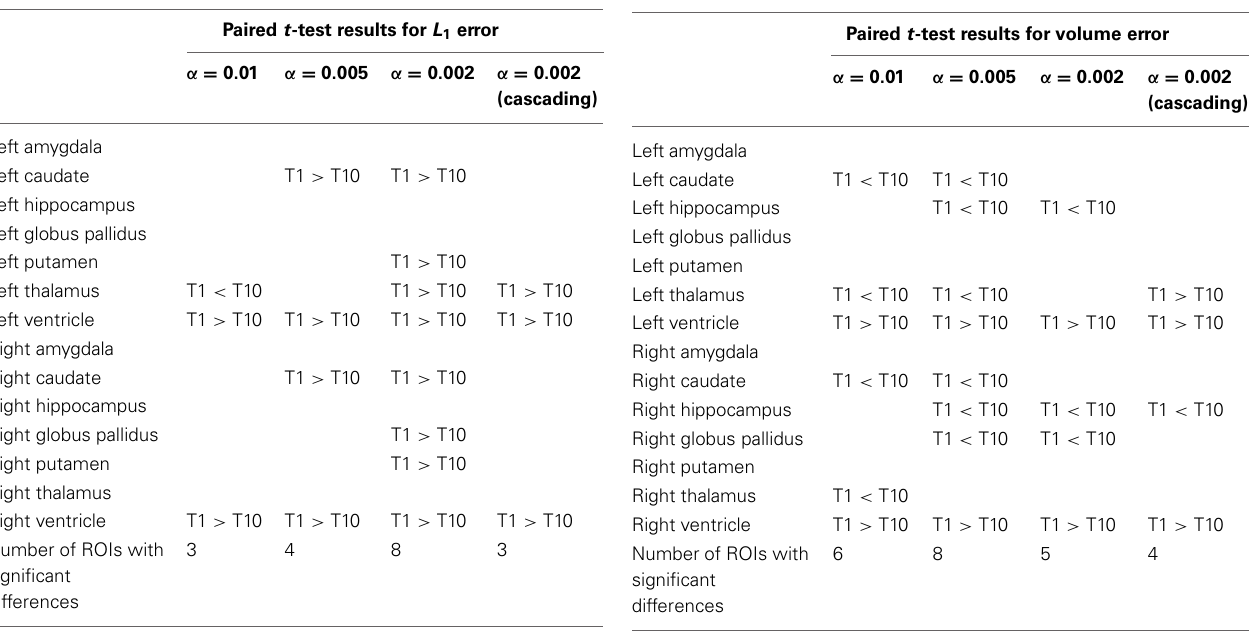
Table 2 | For each ROI and for each α in LDDMM, the volume error results for T = 1 and T = 10 were compared using one sided paired samples t